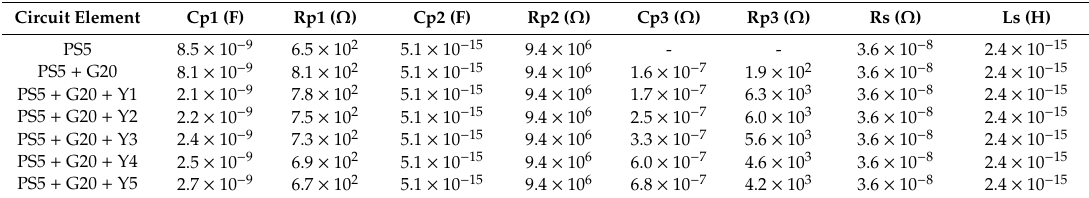
Table A8. Modeled impedance parameters Cp1, Rp1, Cp2, Rp2, Cp3, Rp3, Rs, and Ls of biochip PS5, with 10% glucose as medium and S. cerevisiae .